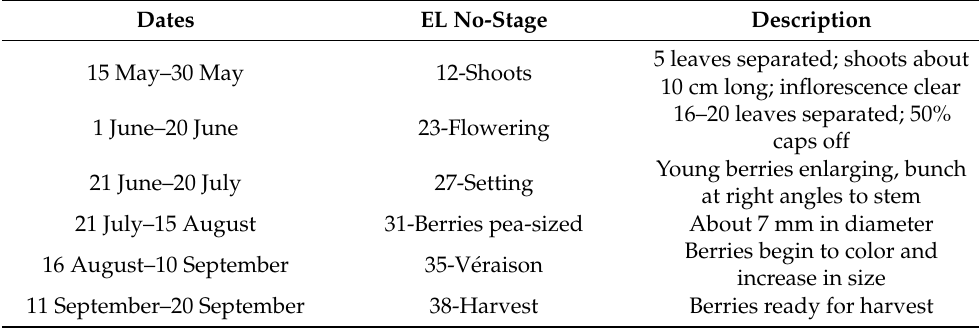
Table 1. Grapevine seasonal EL growth stages of proximal and remote sensing data acquisition. Dates reported in Table 1 relative to both seasons (2019 and 2020).